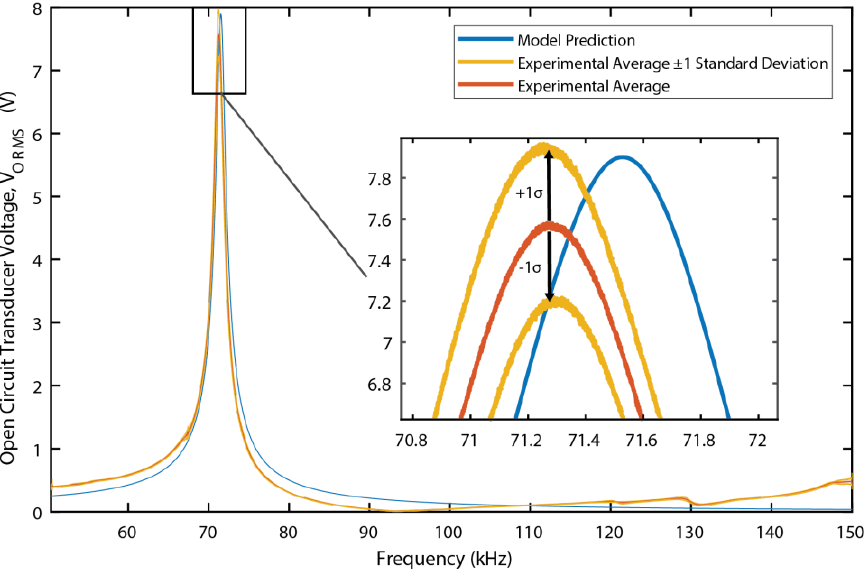
Figure 10. Repeated open circuit voltage vs frequency. Experimental Average, upper and lower deviation, and model prediction shown.